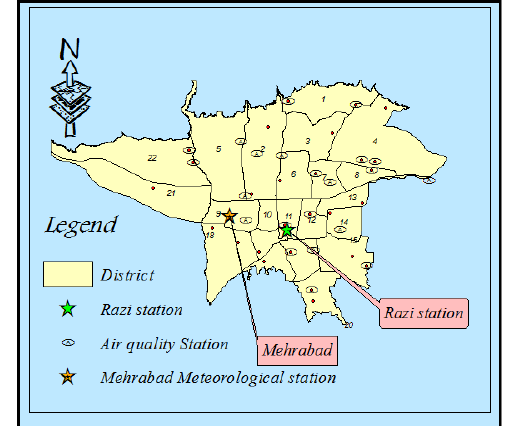
Figure 1. Tehran city, Distribution of air quality stations and Mehrabad meteorological station